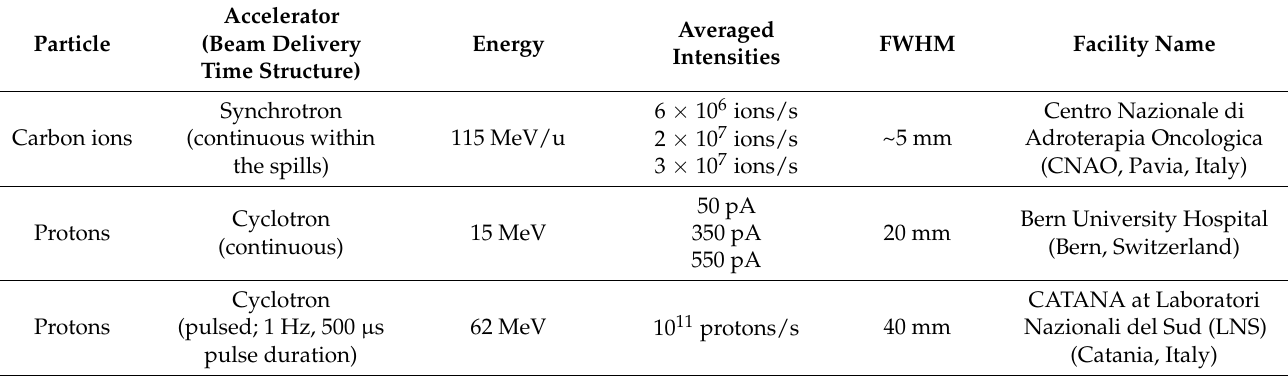
Table 1. Main characteristics of the beams used for the tests presented in this work.